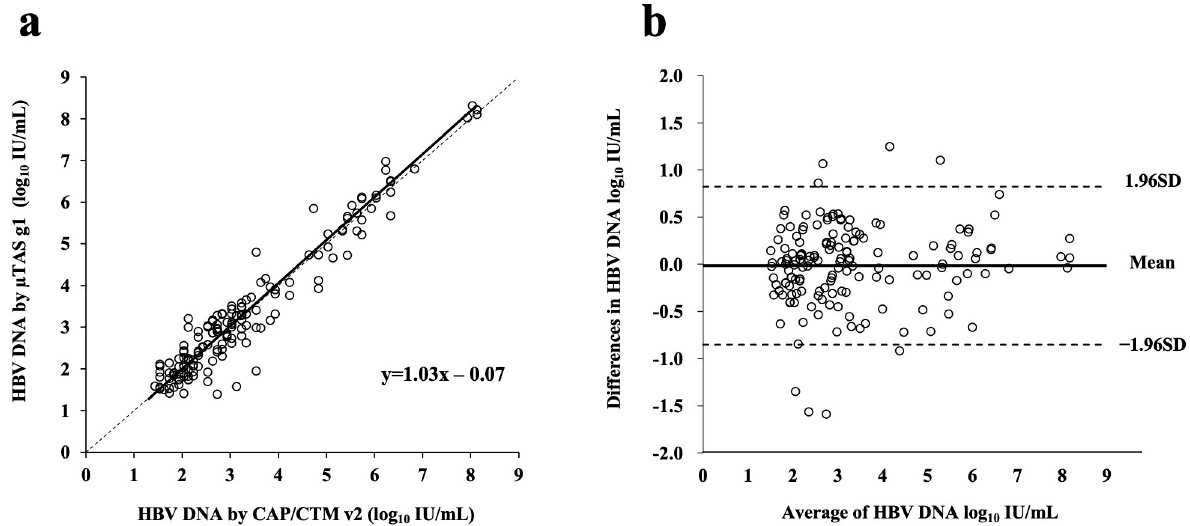
Fig 4. Correlation of measurement and limit of agreement between HBV assays on the μ TASWako g1 analyzer and CAP/CTM v2. A total of 157 serum samples from HBV-infected patients were tested with CAP/CTM v2 and μ TASWako g1 Analyzer. (a) Passing–Bablok regression fit (Solid line). Correlation coefficiency ( r ) was 0.964 (95% CI, 0.959–0.968), P < 0.0001. The dashed line represents the equality line. (b) Bland–Altman plot shows the mean difference between CAP/CTM v2 and μ TASWako g1 Analyzer was − 0.01 (limit of agreement, − 0.82 to − 0.85 log 10 IU/mL). The solid and dashed lines represent the mean difference and mean ± 1.96 SD,